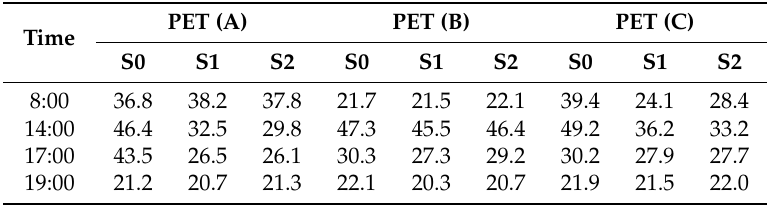
Table 5. Principal PET values in point A, B and C for scenarios S0 (initial condition), S1 (cool pavements + trees) and S2 (cool roofs + cool walls + tress + grass) at 8:00, 14:00 and 17:00, on 1 August